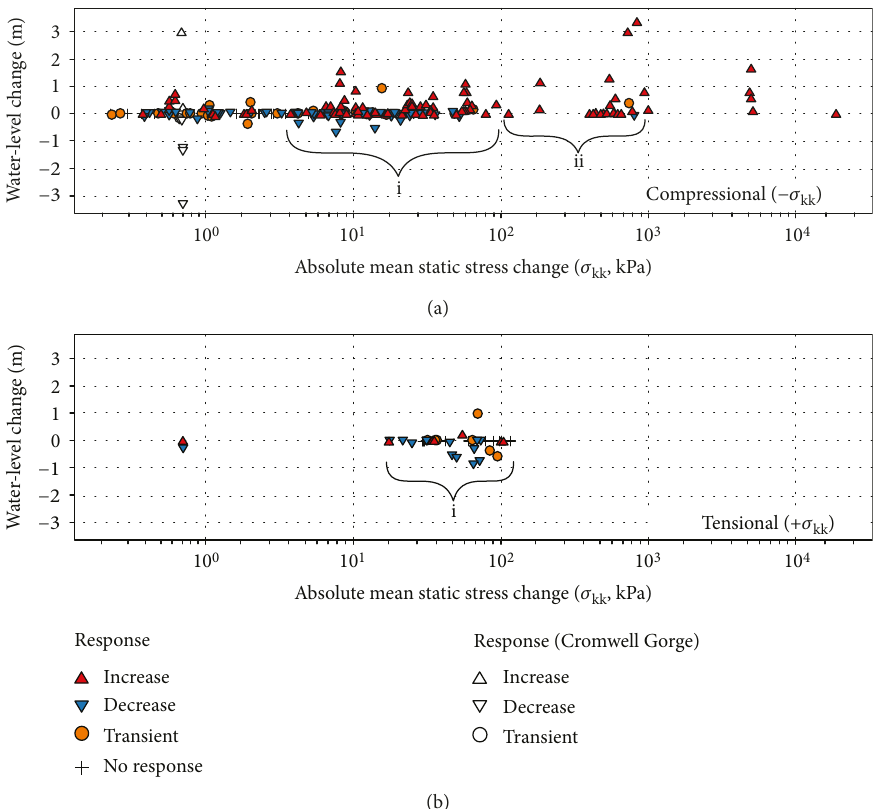
Figure 5: The relationship between earthquake-induced mean static stress changes ( σ kk ) and water level changes. (a) Static stress-induced compressional stress changes. High areas of compressional stress changes include (i) Wellington and Canterbury and (ii) Marlborough. (b) Static stress-induced tensional stress changes. High areas of tensional stress changes include (i)